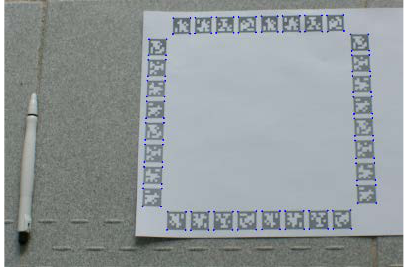
Figure 7. Quadrat Identification.